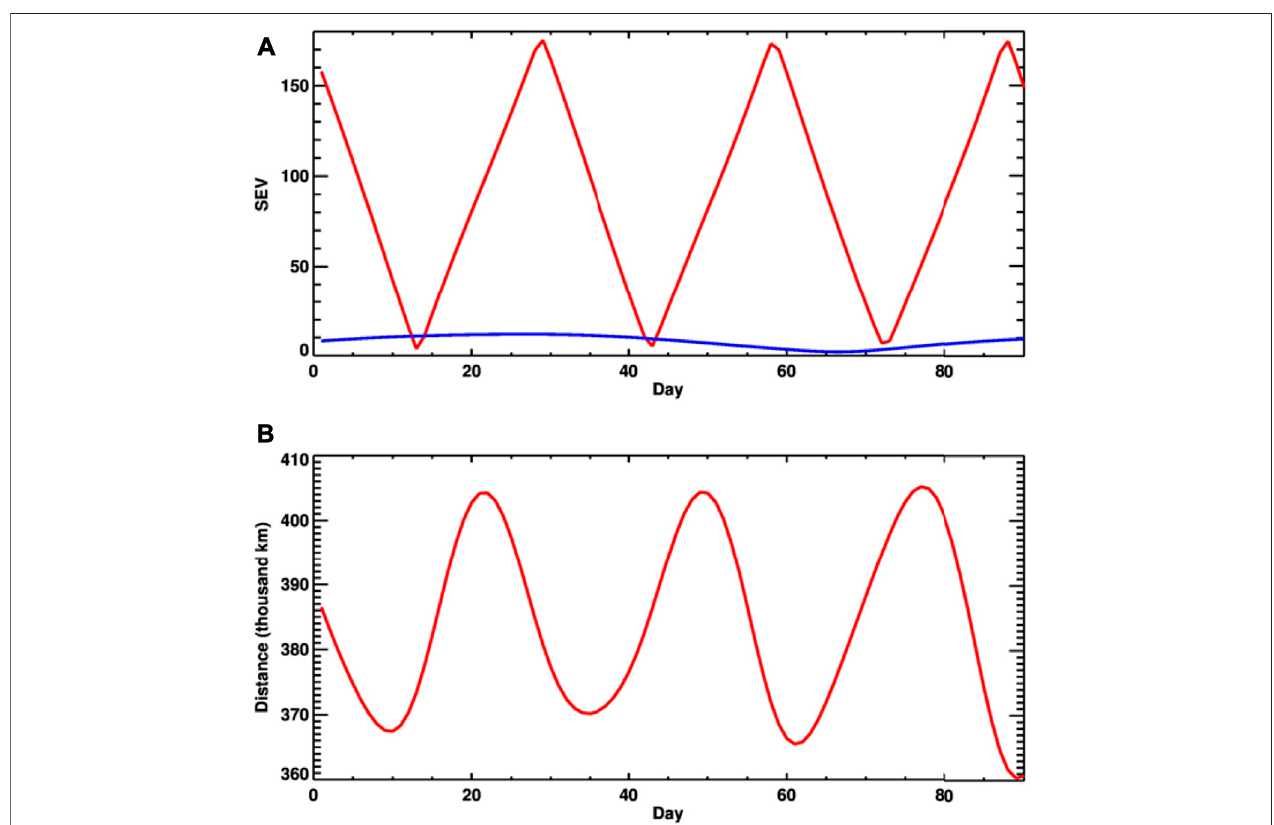
FIGURE 1 | (A) Sun-Earth-Vehicle (SEV) angle for any sunlit Earth object observed from the Moon during the fi rst 3 months of 2021 (red line, data from Espenak, 2021), compared to DSCOVR/EPIC ’ s SEV (blue line, see https://epic.gsfc.nasa.gov/); (B) Distance between the Moon and Earth during the same period (Espenak,